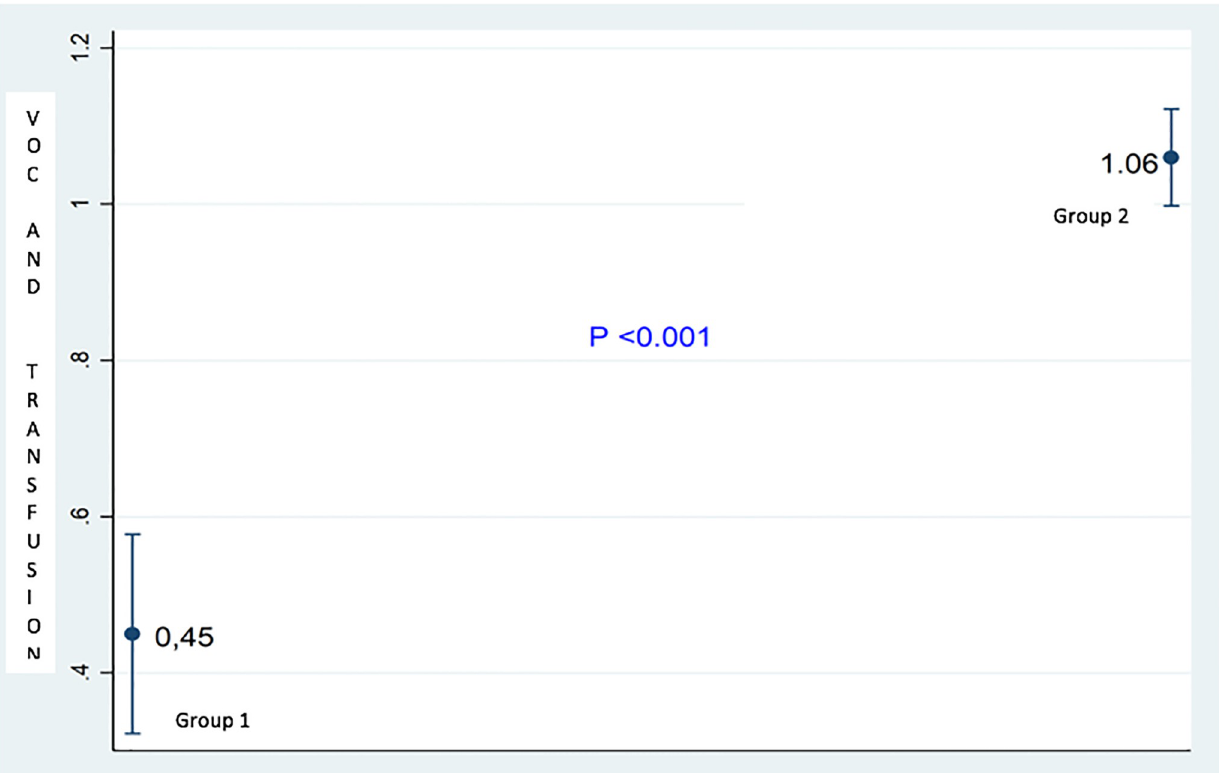
Fig 4. Frequencies of VOCs and transfusions during the crisis of complicated